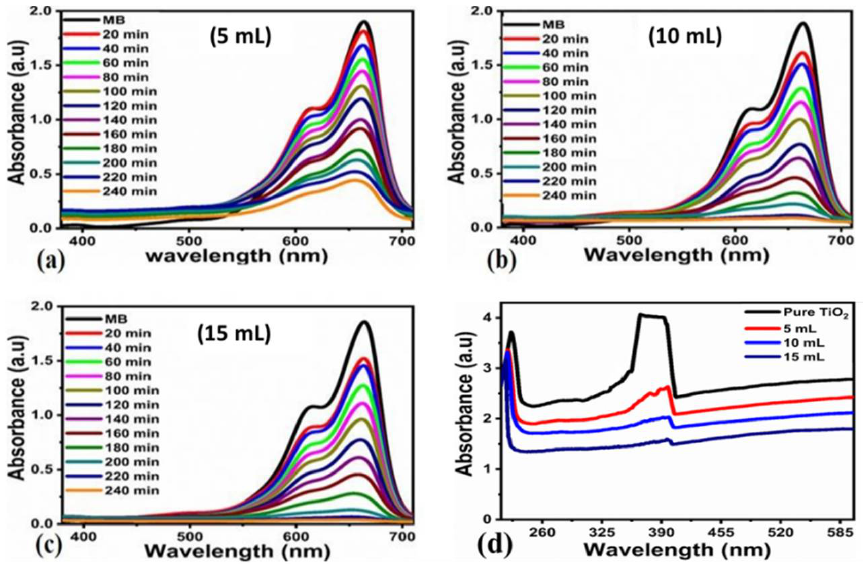
Figure 7. Plot of Ct. Co verses irradiation of photodegradation of MB at various times ( a ), pseudo- first order plot for photodegradation of MB ( b ) and the calibration curve of dye removal (%) under- natural light illumination of bulk TiO 2 material that has been hydrothermally treated with 5, 10, and 15 mL of FC leaf extracts at 30–330 min ( c ).